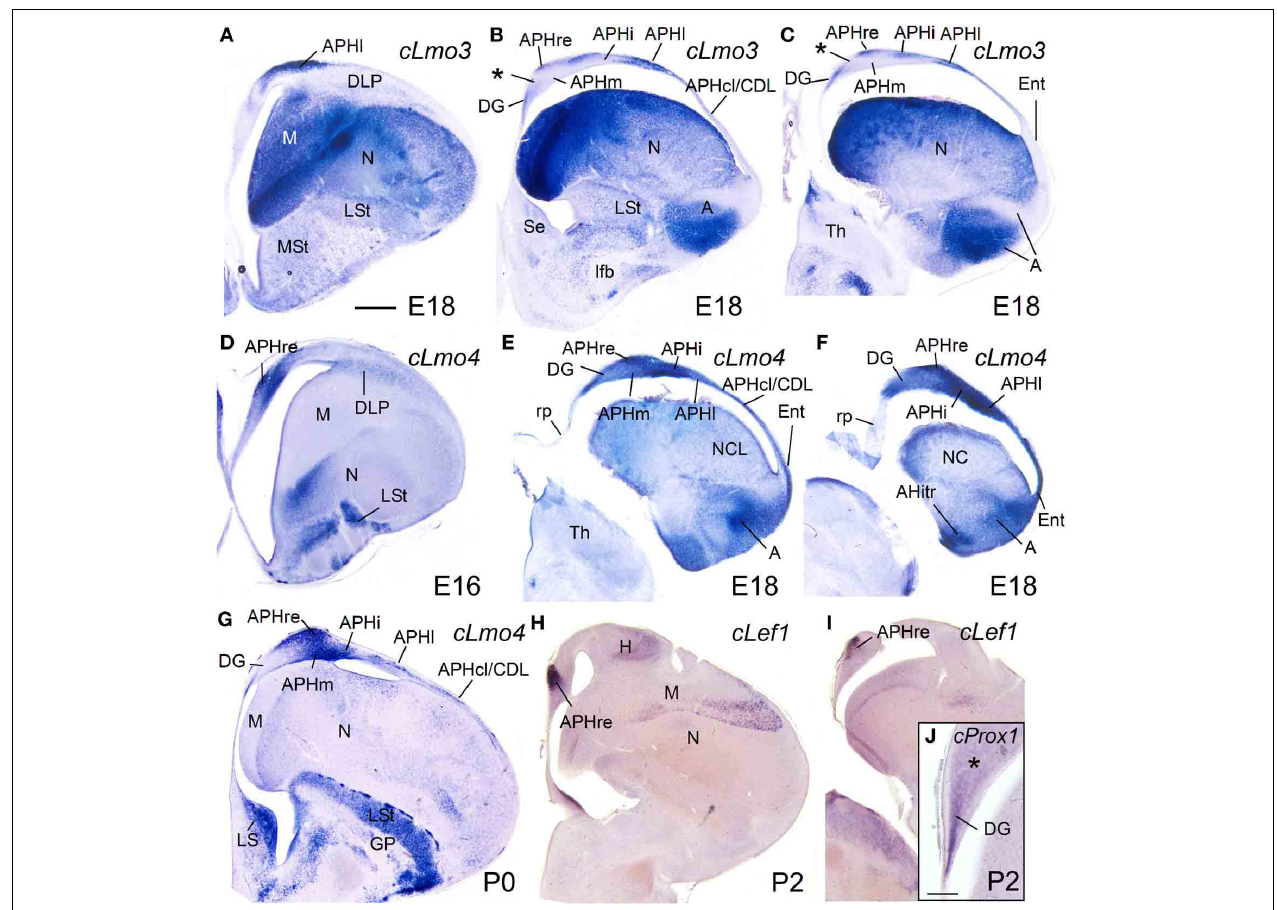
FIGURE 11 | Expression of several genes in the chicken embryonic telencephalon at prehatching and early posthatching stages. Digital images of coronal sections of chicken telencephalon (E16, E18, P0, or P2), at intermediate (A,D,G,H) or caudal (B,C,E,F,I,J) levels, hybridized for cLmo3, cLmo4, cLef1 , or cProx1 . Note the expression of cProx1 in the